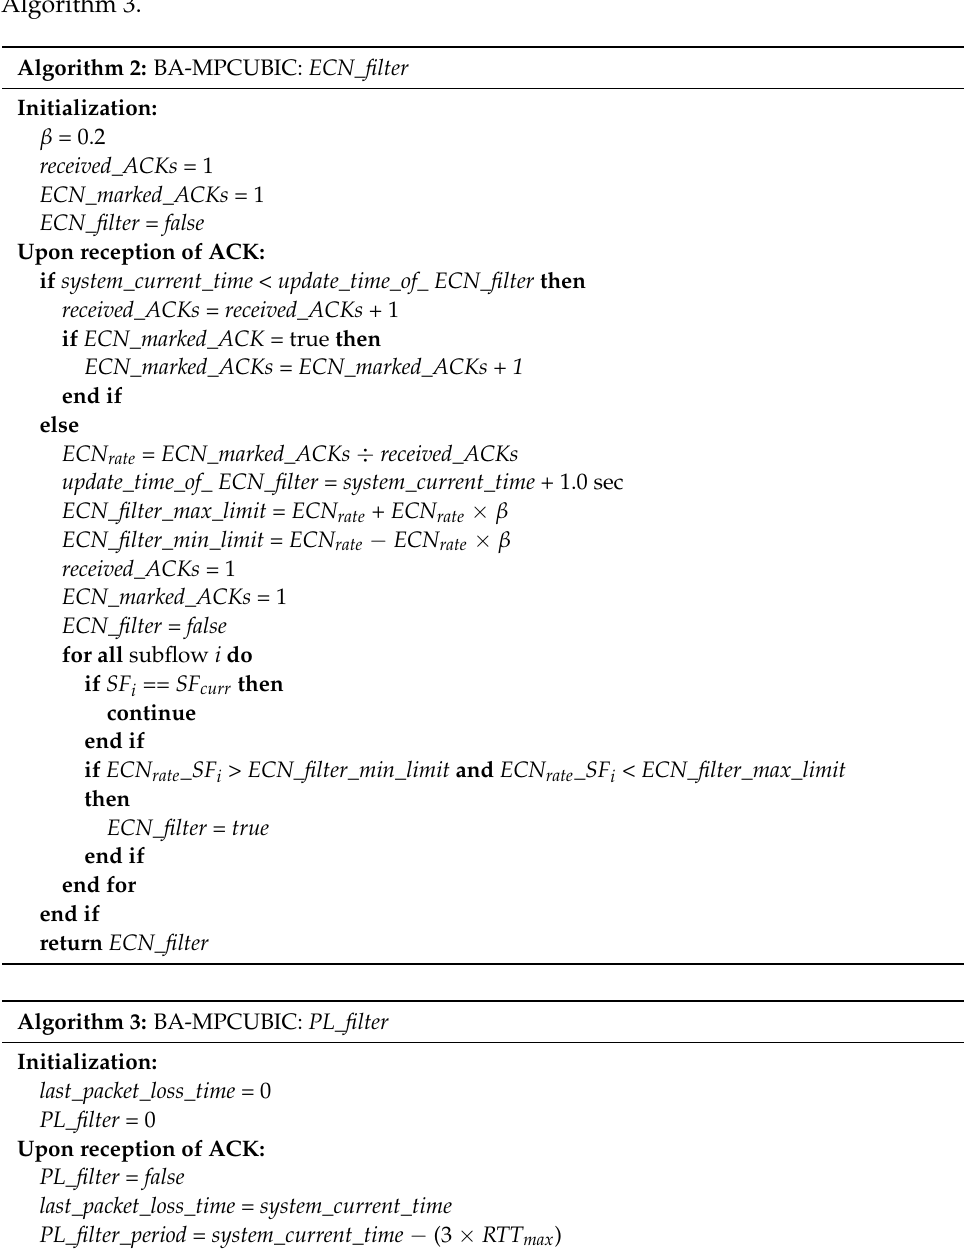
Algorithm 2: BA-MPCUBIC: ECN_filter